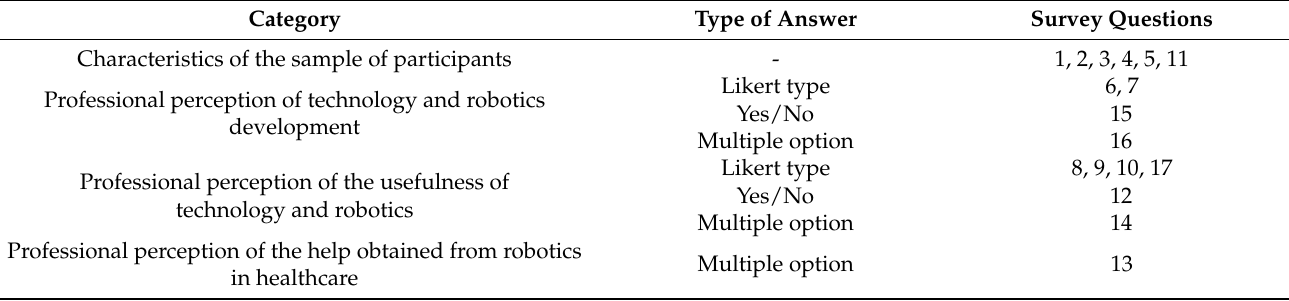
Table 1. Survey question